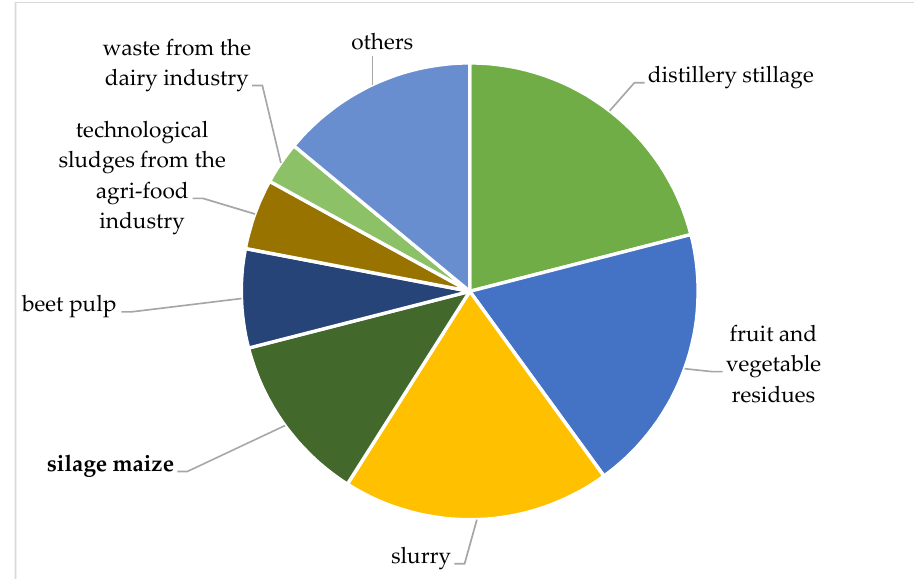
Figure 2. Structure of field green fodder crops production (Total production of field green fodder crops = 100. Source: own elaboration based on [36].